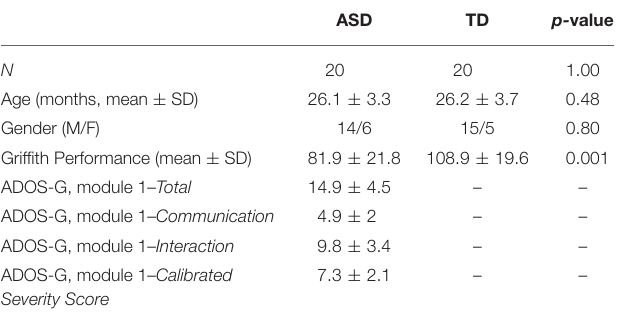
TABLE 1 | Study population (significance: p <